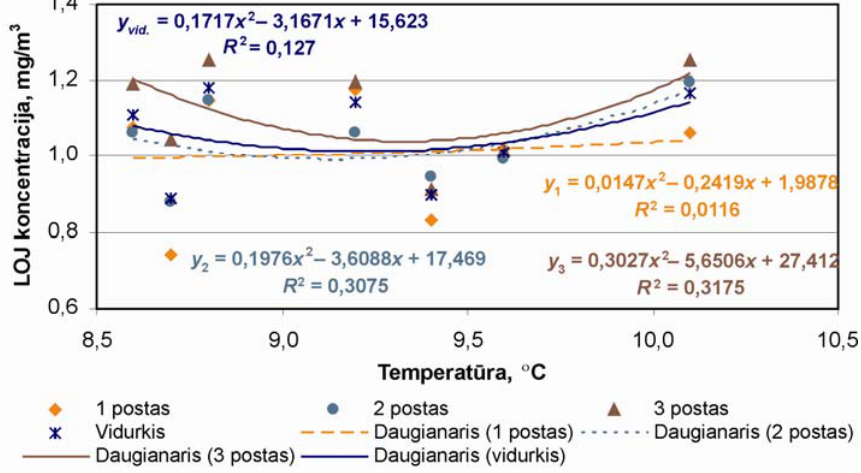
Fig 6 . Dependence of VOC concentration in ambient air on temperature (7-day results)